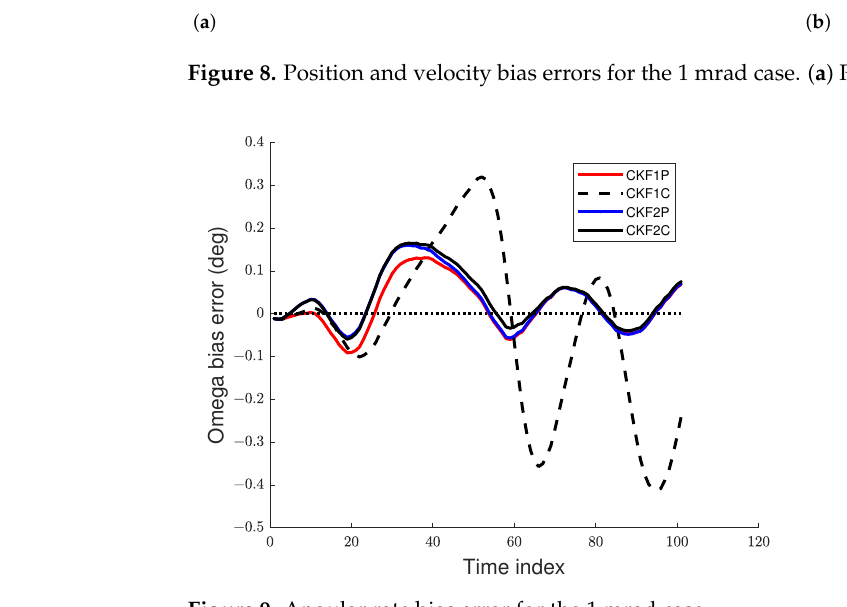
Figure 9. Angular rate bias error for the 1 mrad